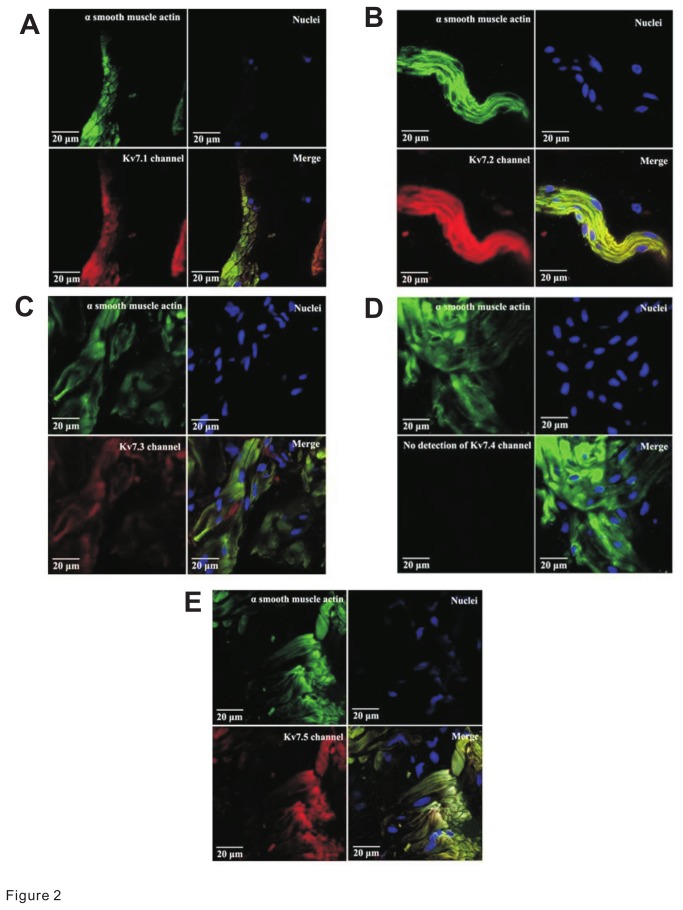
Protein expression of Kv7 channel subtypes in guinea pig DSM.Confocal images illustrate the staining for Kv7.1 (A), Kv7.2 (B), Kv7.3 (C), Kv7.4 (D), and Kv7.5 (E) channel subtype proteins in mucosa-free whole DSM tissue. Kv7 channel subtype proteins were detected by immunohistochemistry using subtype-specific antibodies. In all panels, α-smooth muscle actin is shown in green; cell nuclei are illustrated in blue; the specific Kv7 channel subtype protein expression is represented by red staining. The merged images of α-smooth muscle actin, nuclei, and the Kv7 channel protein expression are illustrated in the quadrant labeled “Merge”. Images were captured with a Carl Zeiss LSM 700 META confocal microscope (63x objective). Experiments were conducted on DSM tissue samples isolated from 3 different guinea pigs.